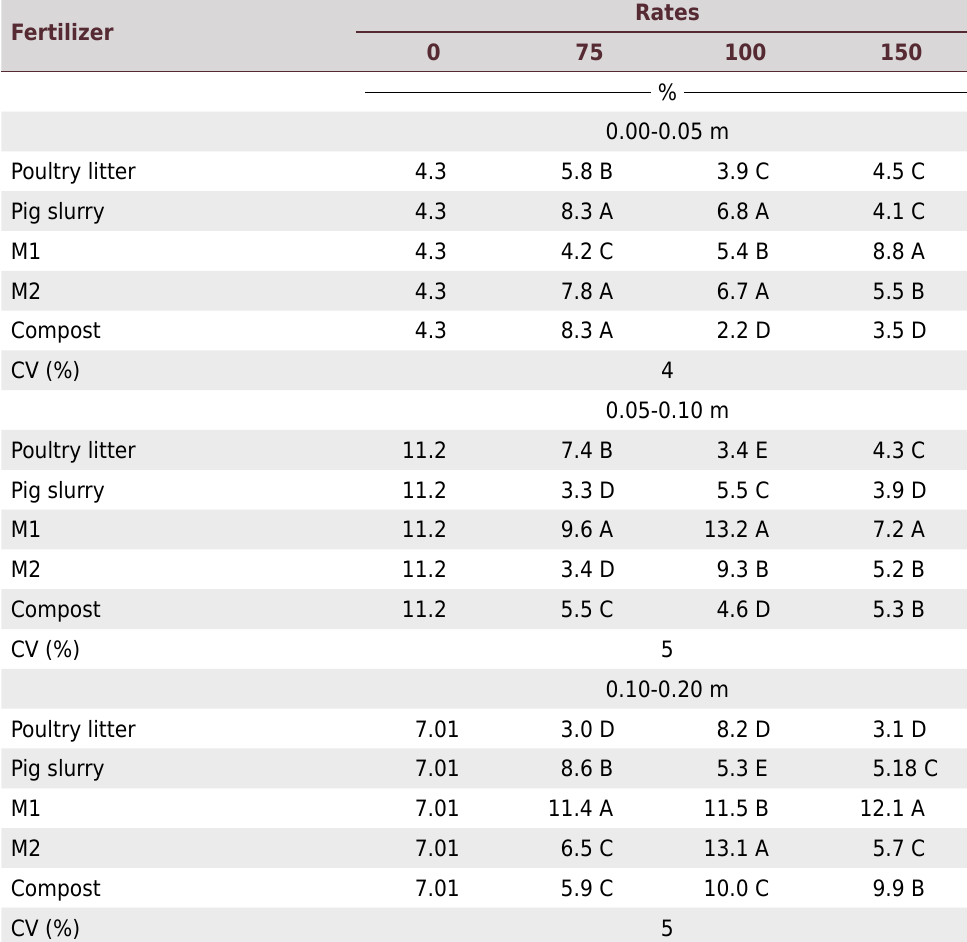
Table 5. Percentage of aggregates of the class (C2 4.76 to 2.00 mm) from a Rhodic Kandiudox, in layers of 0.00-0.05, 0.05-0.10 and 0.10-0.20 m after seven years of application of types and rates (%) of organic and mineral fertilizers